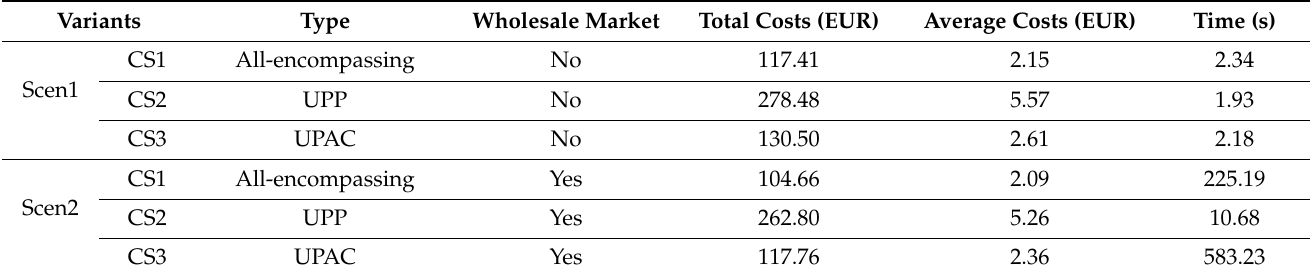
Table 2. Optimization